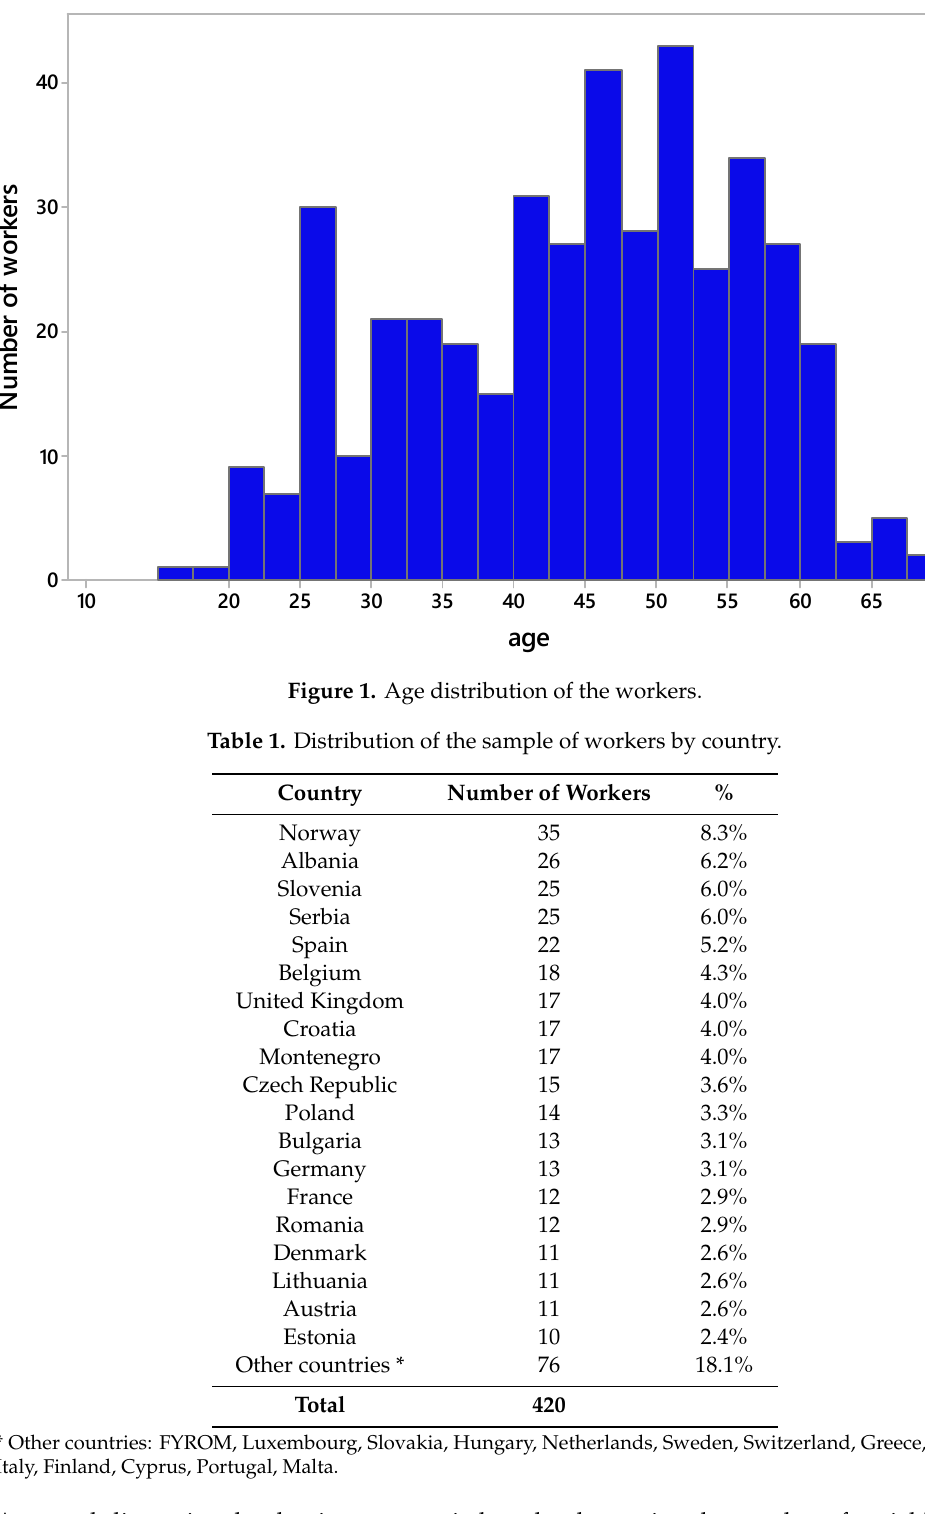
Table 2. Distribution of the sample of workers according to the level of studies (ISCED). Level of Studies (ISCED)